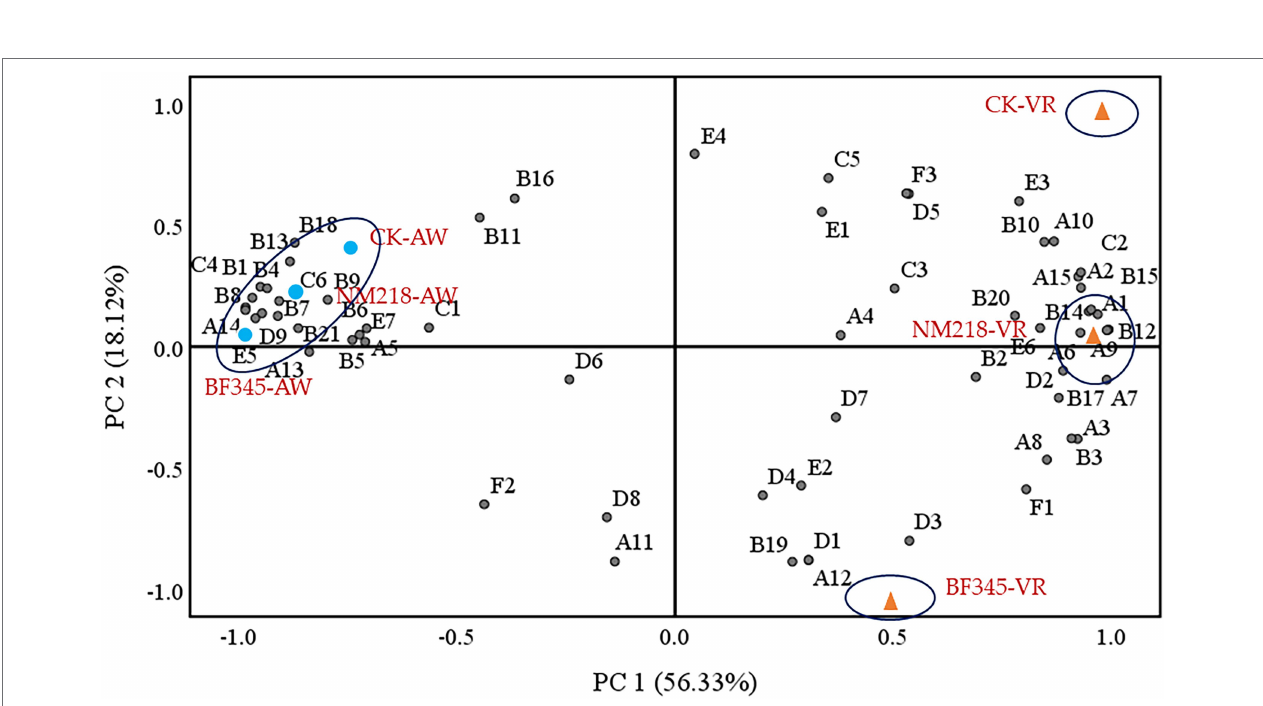
FIGURE 5 | PCA of wine aroma compounds. A denotes higher alcohols, B denotes esters, C denotes fatty acids, D denotes terpenes, E denotes aldehydes and ketones, and F denotes other compounds. CK-VR; pure culture of S. cerevisiae (VR) used as a control in Cabernet Sauvignon wines. NM218-VR; sequential inoculation of M. guilliermondii NM218 and VR at 48 h in Cabernet Sauvignon wines. BF345-VR; sequential inoculation of H. uvarum BF345 and VR at 24 h in Cabernet Sauvignon wines. CK-AW; pure culture of S. cerevisiae (AW) used as a control in Chardonnay wines. NM218-AW; sequential inoculation of M. guilliermondii NM218 and AW at 48 h in Chardonnay wines. BF345-AW; sequential inoculation of H. uvarum BF345 and AW at 24 h in Chardonnay